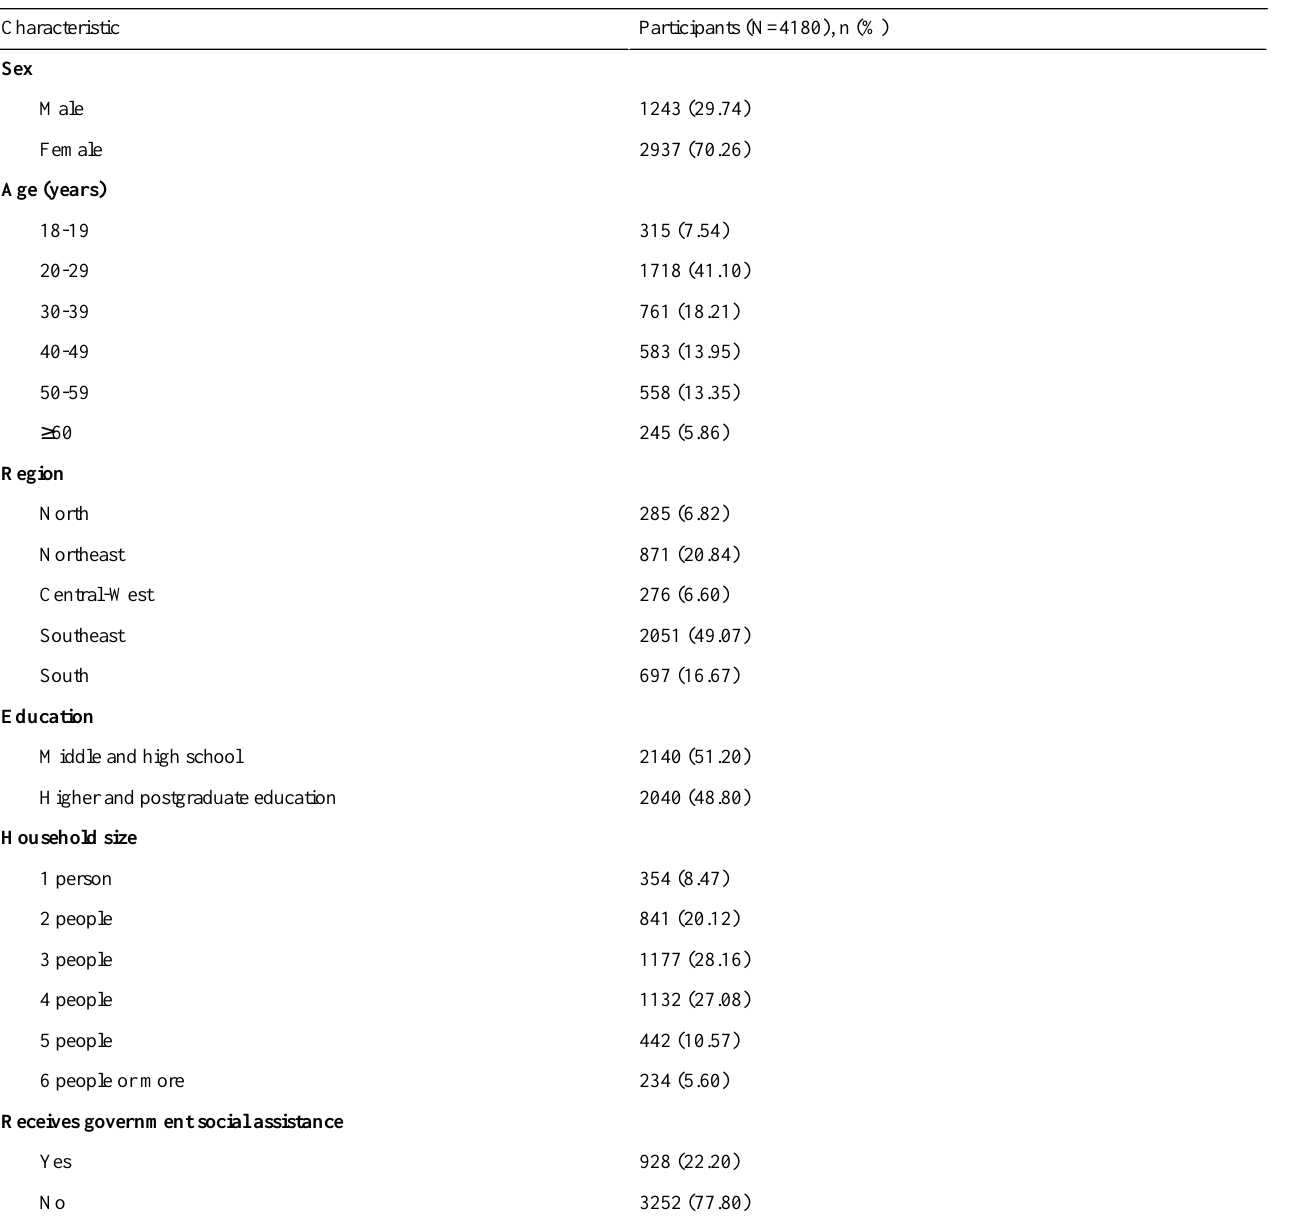
Table 1. Demographic characteristics of